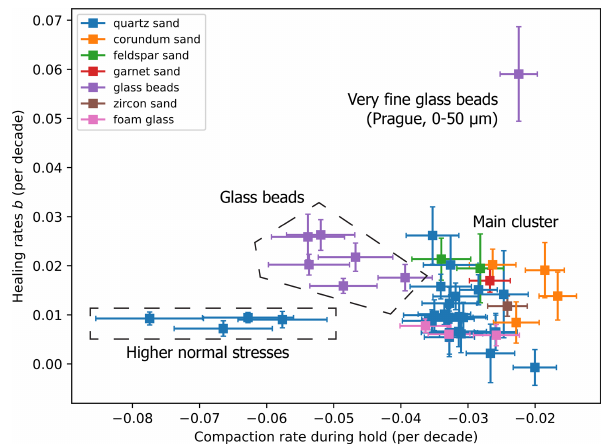
Figure 5. Comparison of healing rate and compaction rate. Materi- als that behave similarly are grouped in